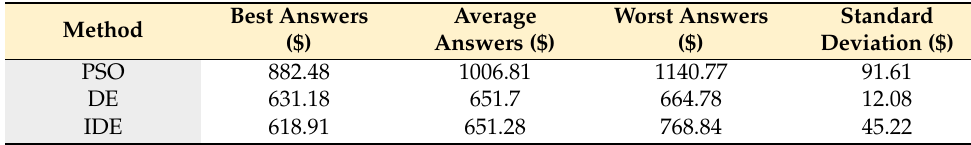
Table 7. Comparison of the proposed method with other methods for reducing costs without considering the limitations of upstream network power